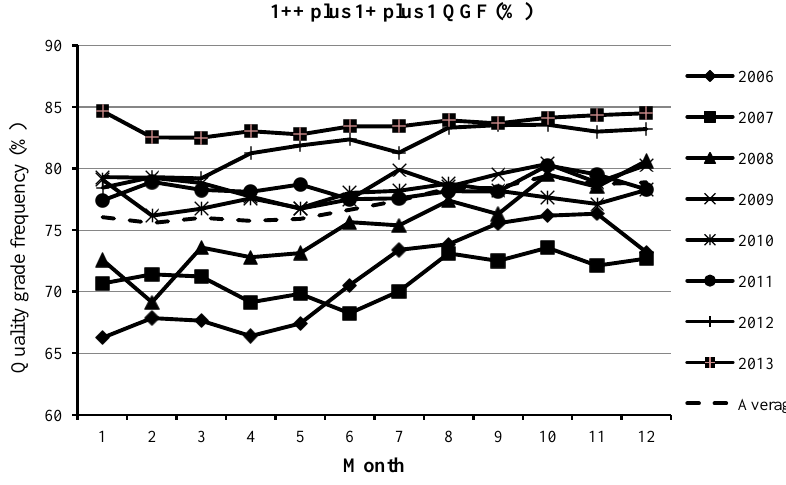
Figure 1. Monthly comparison of 1++ plus 1+ plus 1 quality grade frequency (QGF) in Korean cattle steers for 8